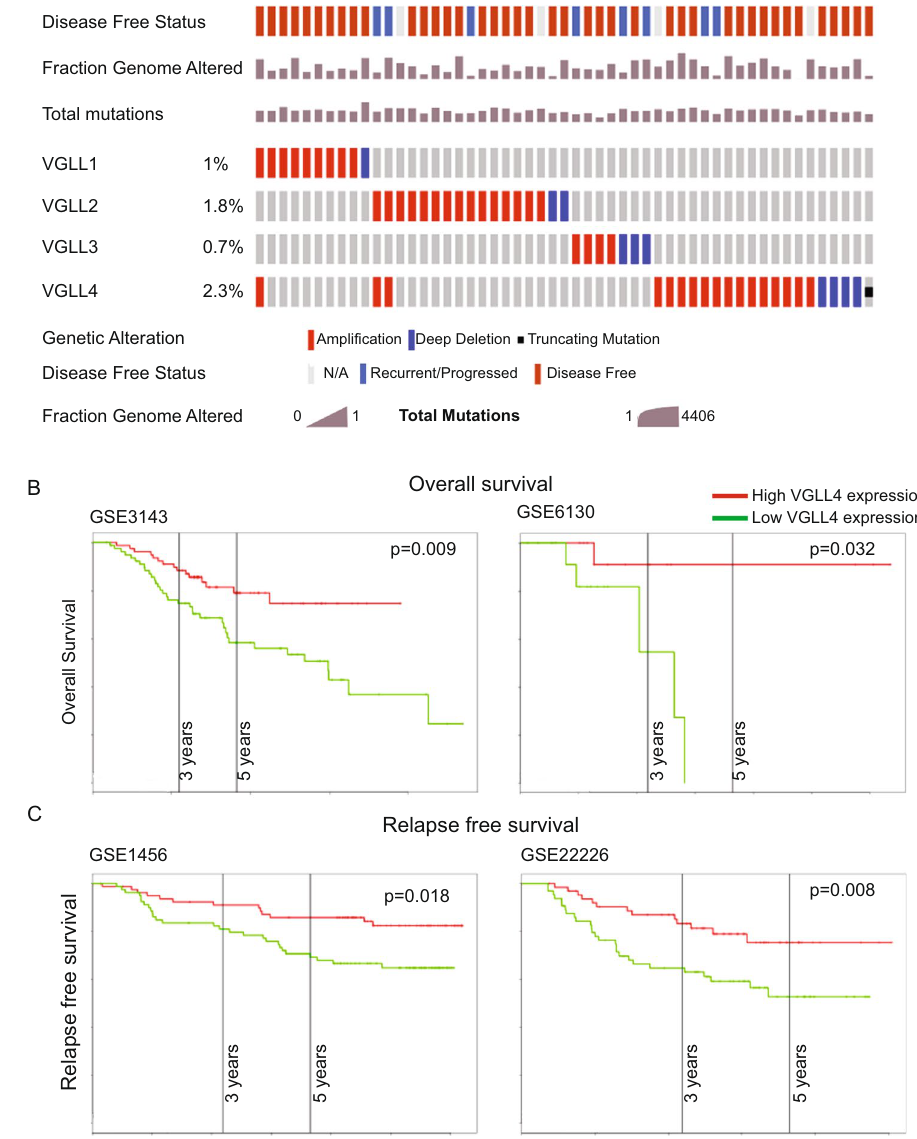
Figure 1. Coordinated analysis of VGLL1-4 mutation status and correlations with the genomic and clinical breast cancer features. ( A ) VGLL1-4 genetic alterations in 817 breast invasive carcinoma samples from TCGA. Copy number variation (CNV and mutation status normalized with MANCIE. Significantly mutated genes with frequent copy number amplifications (red) or deletions (blue) are shown. Average mutation rate is indicated. ( B ) Kaplan-Meier overall survival (OS) and ( C ) relapse-free survival (RFS) analysis of breast cancer patients using a median split of VGLL4 gene expression (KM-plotter). The Log Rank test was used to measure the statistical difference between the high and low VGLL4 groups for Kaplan-Meier curves. One-way ANOVA was used to measure the differences in VGLL4 expression in breast cancer patients of various subtypes. X -axis: follow-up time in years; y -axis: cumulative survival. Four independent patient data sets were used from the Gene Expression Omnibus (GSE3143, GSE6130, GSE1456 and